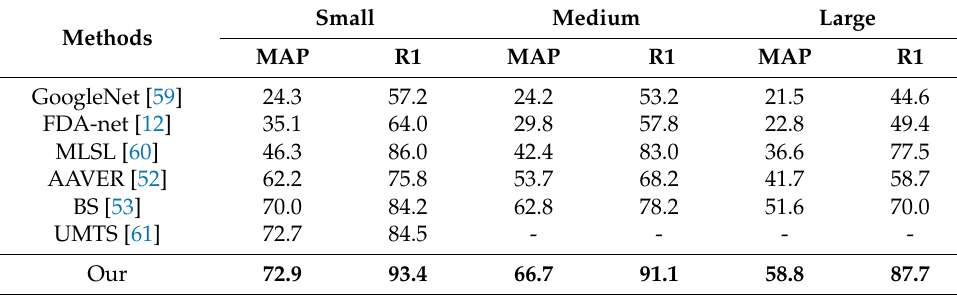
Table 5. Comparison of the Sota on VERI-Wild (%).